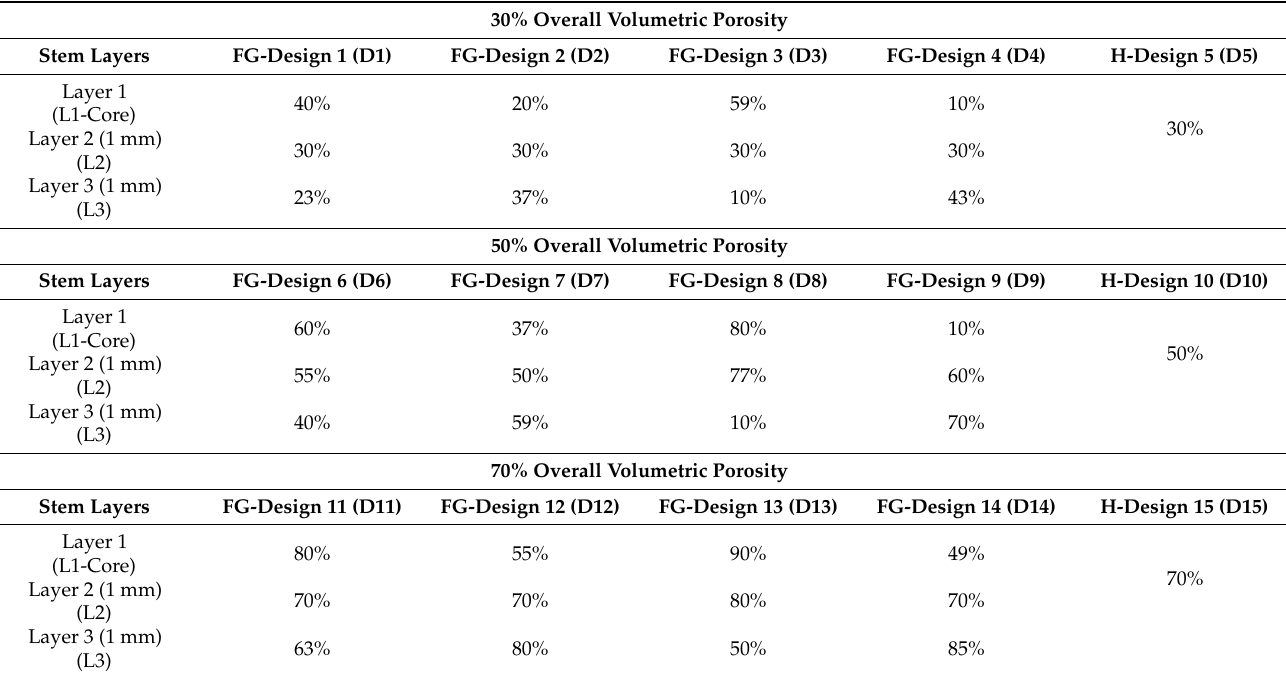
Table 1. Porous functionally graded (FG) and homogeneous (H) designs introduced to stem redial layers. 30% Overall Volumetric Porosity